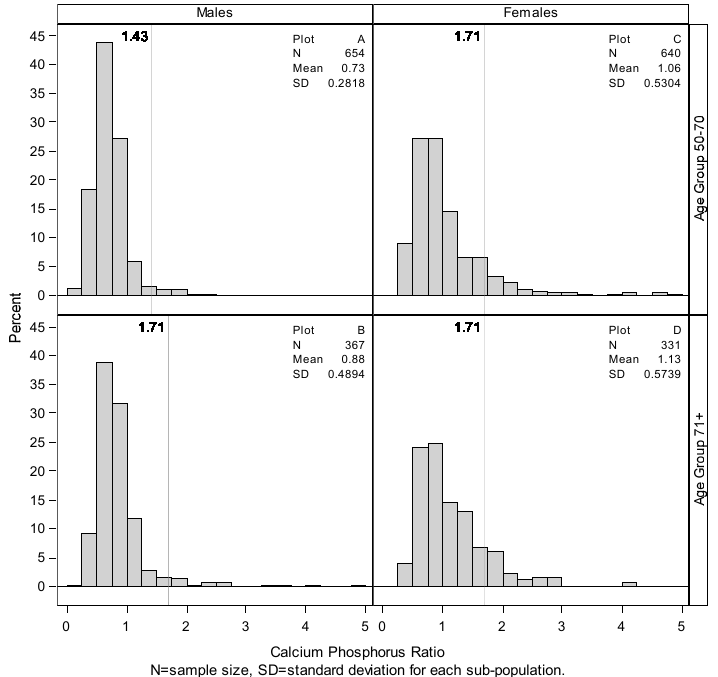
sub-population.Calcium Phosphorus Ratio N=sample size, SD=standard deviation for each Figure 3. Summary and distributions of estimated Ca:P ratio. Histogram showing the distribution of Ca:P ratio by gender and age group with vertical line representing the mean Ca:P ratio based on Ca and P RDAs (by mass). More than 98.32% of the younger males had Ca:P ratios less than the calculated RDA value of 1.43, plot A . Older males had a similar percentage below their calculated RDA-based ratio of 1.71, plot C . Among females, 93.64% of the younger group and 92.22% of the older group had a Ca:P ratio lower than the calculated RDA value of 1.71.